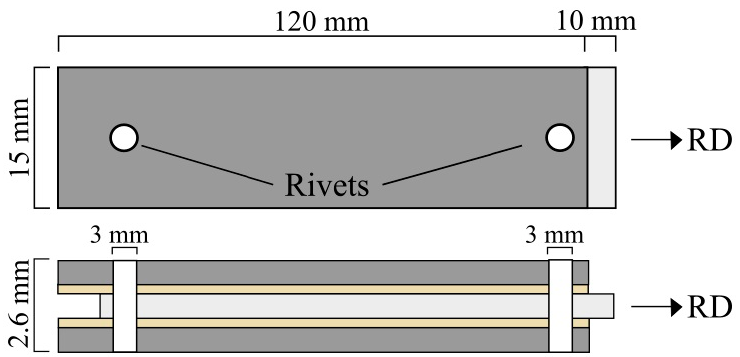
Figure 1. Illustration showing the initial measurements of one composite consisting of five layers in the stacking sequence; steel / nickel / aluminum / nickel / steel. Aluminum rivets (diameter 3 mm) were placed in the front and rear end of the composite. RD indicates the rolling direction.